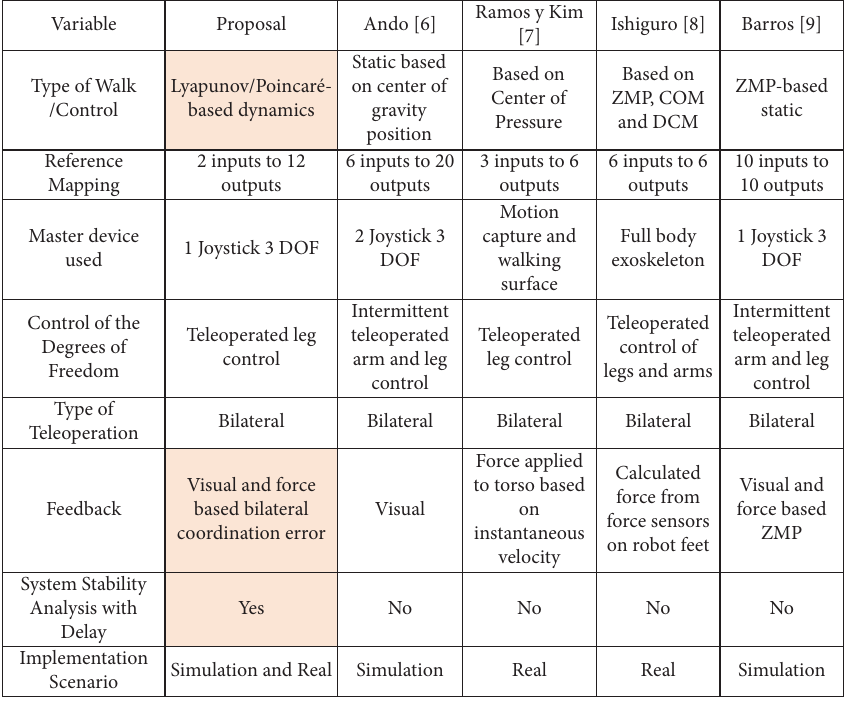
Figure 2: Comparative